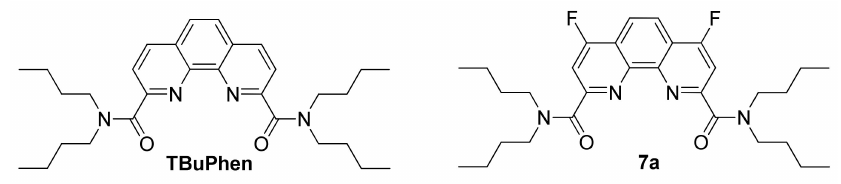
Figure 6. Structural formulas of TBuPhen and 7a ligand.